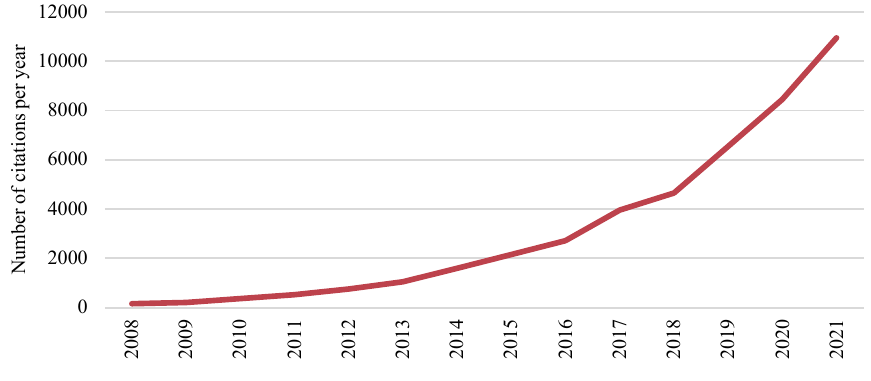
Fig. 4. Number journal article citations on topic of biobased epoxy.